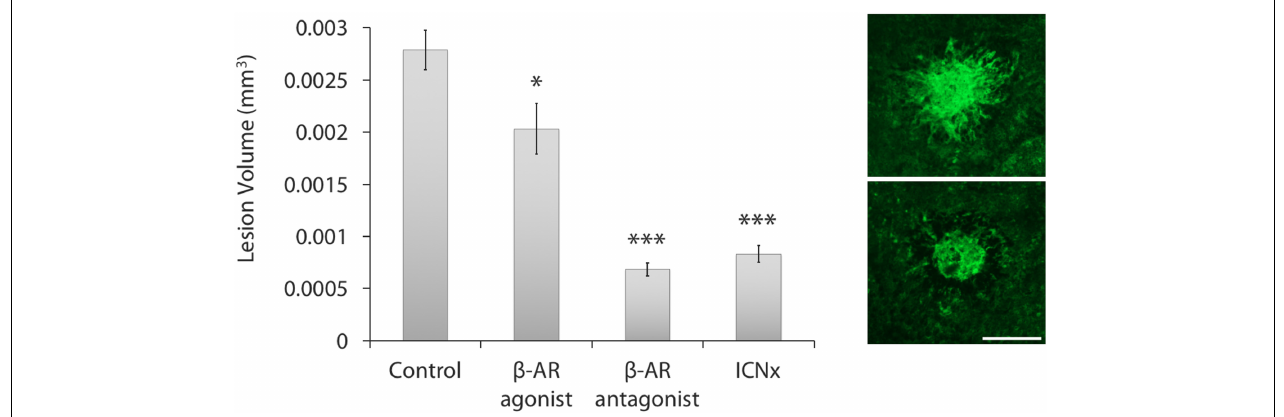
FIGURE 2 | β -AR modulation leads to smaller laser-induced CNV lesions. (Left) All three treatment groups had statistically smaller lesions than the control group ( n ≥ 30 lesions per group from five animals per group; ∗∗∗ P < 0.001; ∗ P < 0.05). Lesions in the propranolol and ICN transection groups were statistically similar in size ( P = 0.16). Error bars represent SEM. (Right) Images of CNV membranes, stained with FITC-labeled isolectin-B4, showing representative lesions from the control group (top) and ICN transection group (bottom). Scale bar = 200 µ m.